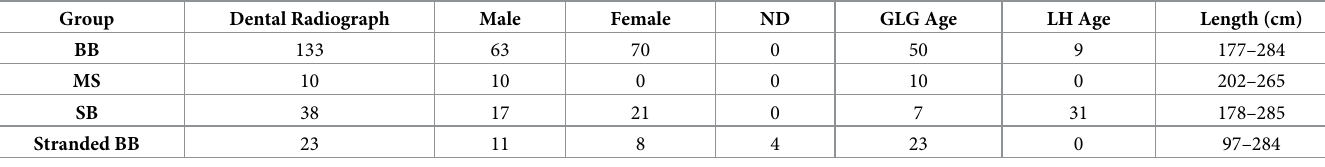
Table 1. Sample sizes for each age determination technique by sample